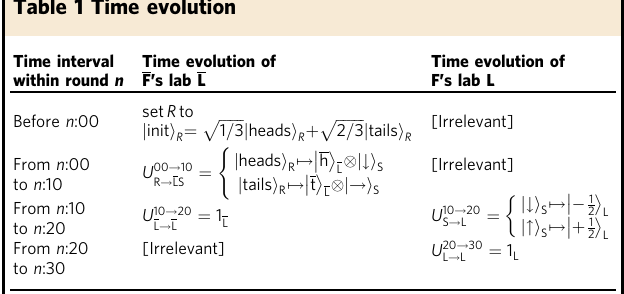
Heisenberg projectors used for reasoning via (Q)